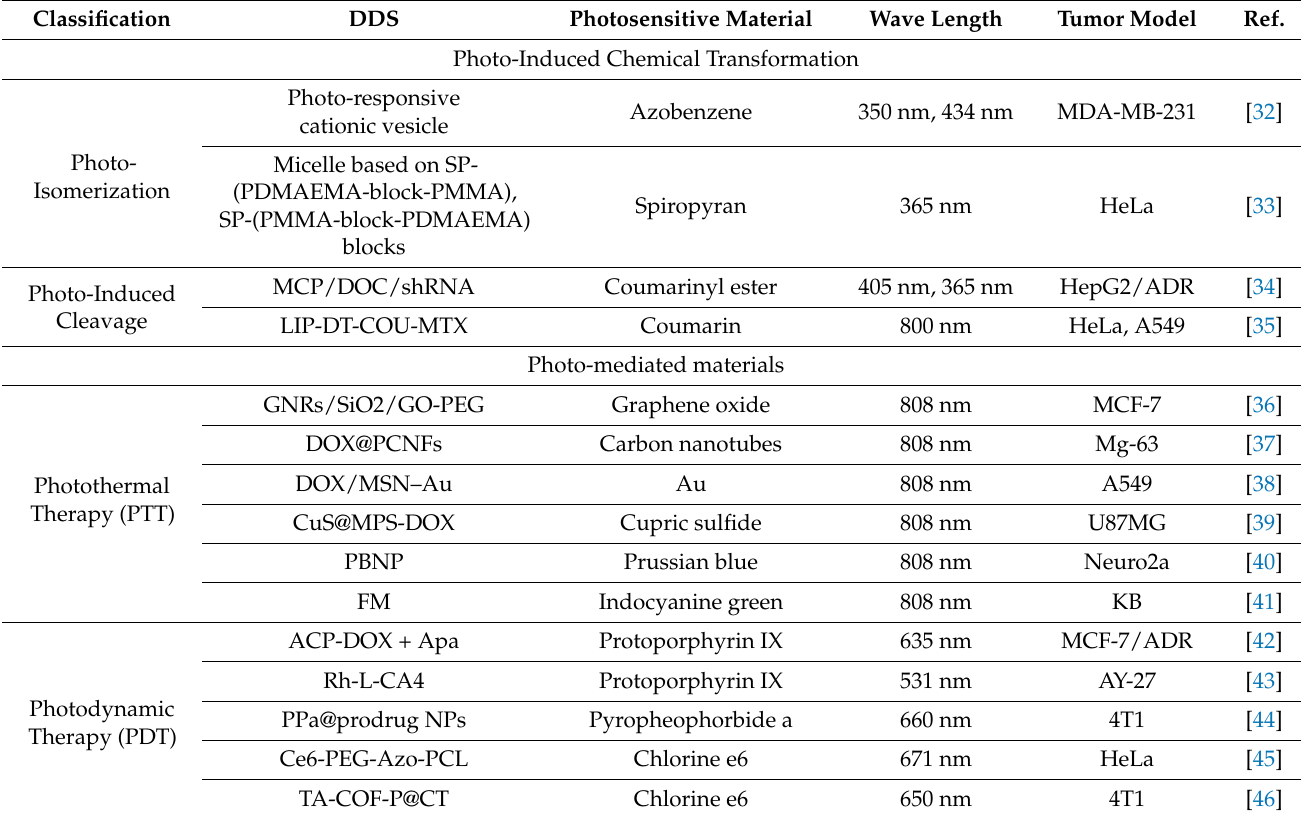
Table 1. Summary of representative photo-responsive